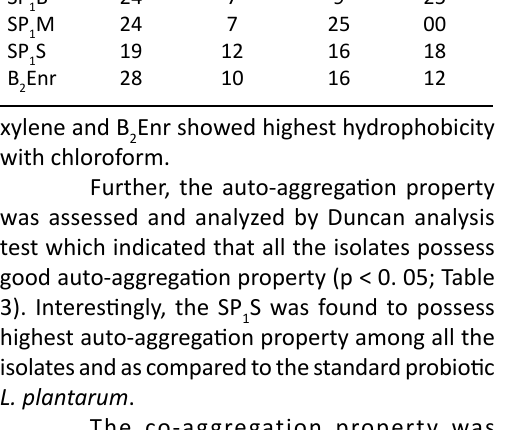
Table 2. Antibacterial activity of isolates against different indicator microorganisms Isolates Diameter of zone of inhibition (in mm) against indicator bacteria E. P. S. P. coli aeruginosa aureus